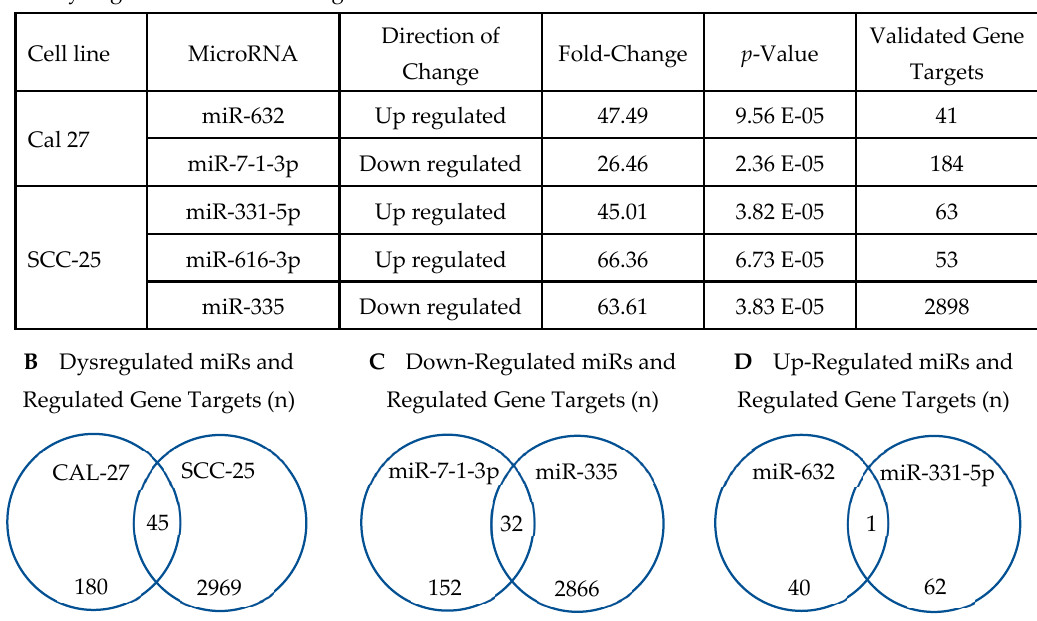
Figure 1. Summary of Significantly Dysregulated miRs following Vitamin D Treatment of Head and Neck Cancer Cell Lines. ( A ) Vitamin D altered miRs in CAL-27 and SCC-25 cells, the direction of change, and the number of validated gene targets regulated by each miR with 45 overlapping genes. ( B ) Validated gene targets regulated by Vitamin D modulated miRs in CAL-27 and SCC-25 cells and overlapping gene targets. ( C ) Specific miRs down regulated by Vitamin D in CAL-27 and SCC-25 cells, with overlapping genes identified ( n = 32). ( D ) Up-regulated miRs showing individual results and overlapping gene targets ( n = 1).